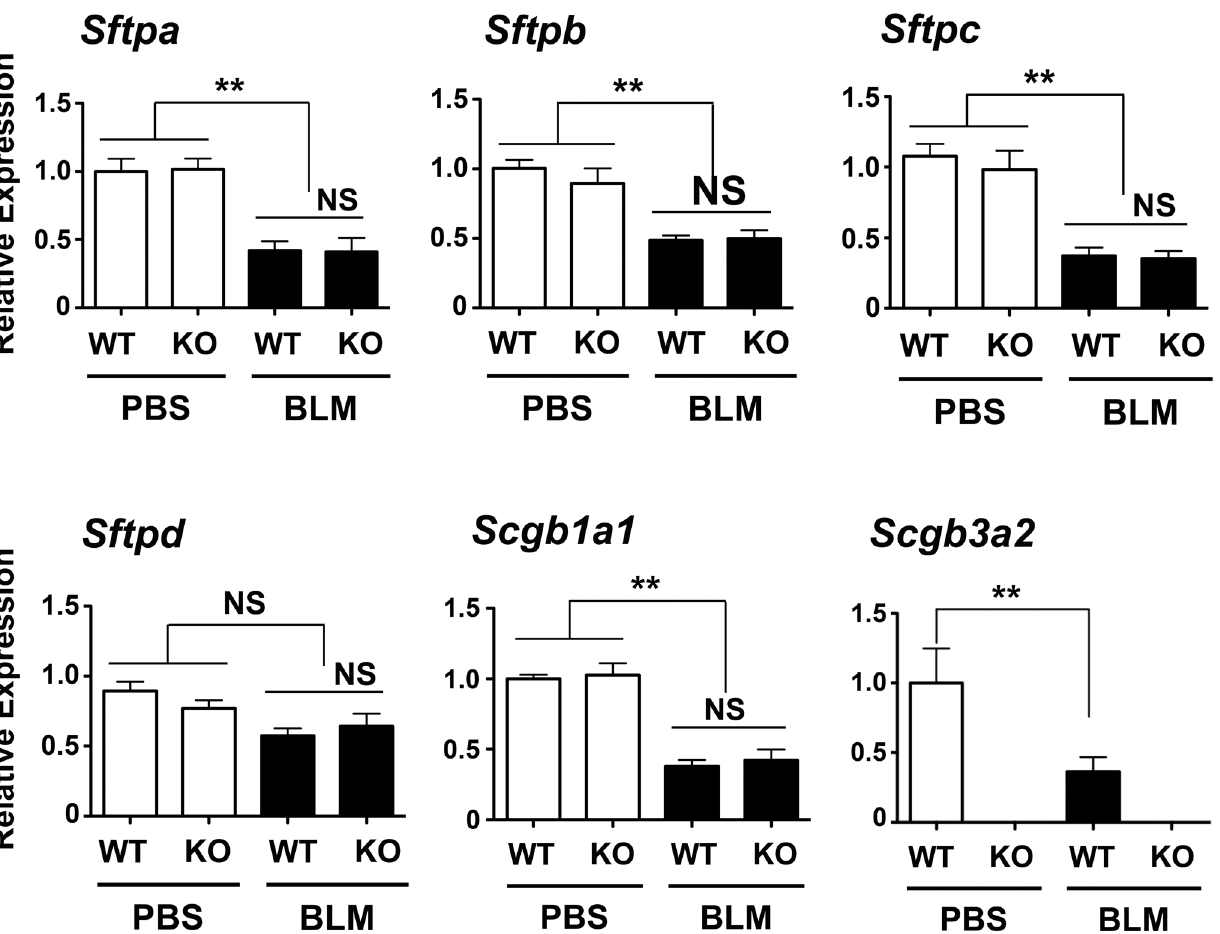
Fig 5. Analysis of mRNAs for surfactant proteins and SCGB proteins. qRT-PCR was carried out to determine levels of mRNAs encoding SPA ( Sftpa ), SP-B (S ftpb ), SP-C ( Sftpc ), SP-D ( Sftpd ), Scgb1a1 and Scgb3a2 in the lungs of wild-type (WT) and Scgb3a2 -null (KO) mice intubated with BLM or PBS as control. The normalization control was 18S. Relative expression levels with the mean ± SD from N > 8 in each group are shown. ** P < 0.01 by one-way ANOVA. NS: not